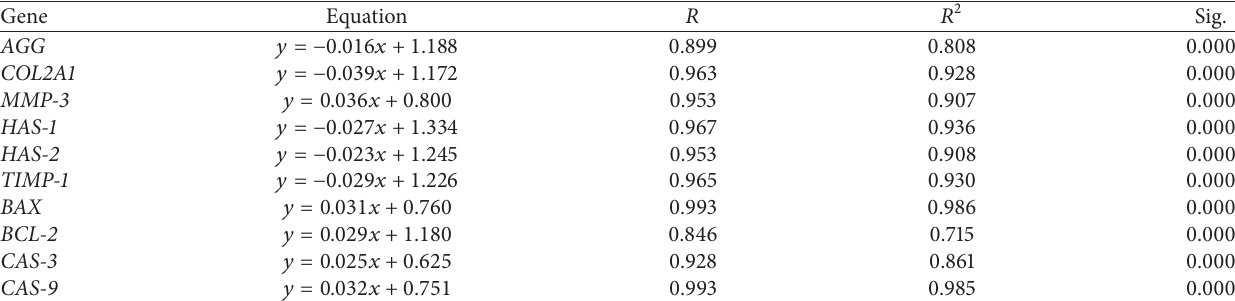
Table 2: Linear regression equation 𝑅 , 𝑅 2 , and significance level (Sig.) of candidate